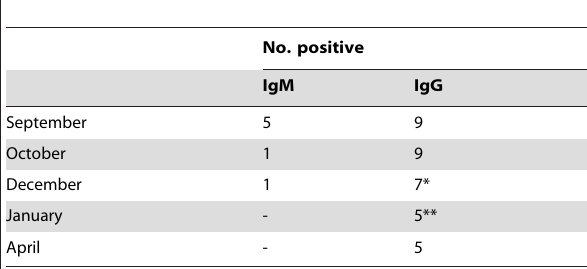
Table 5. Number of RVF seropositive animals in the longitudinal